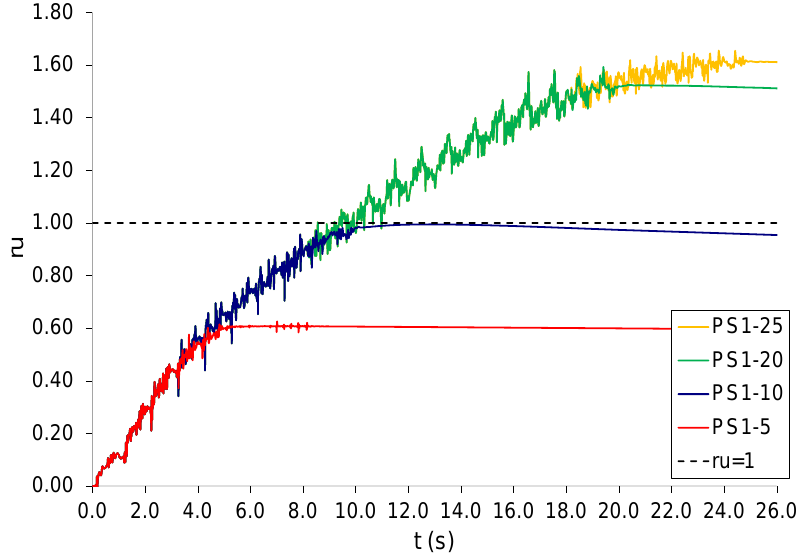
Figure 6. Pore pressure ratios versus time for parametric study PS1.